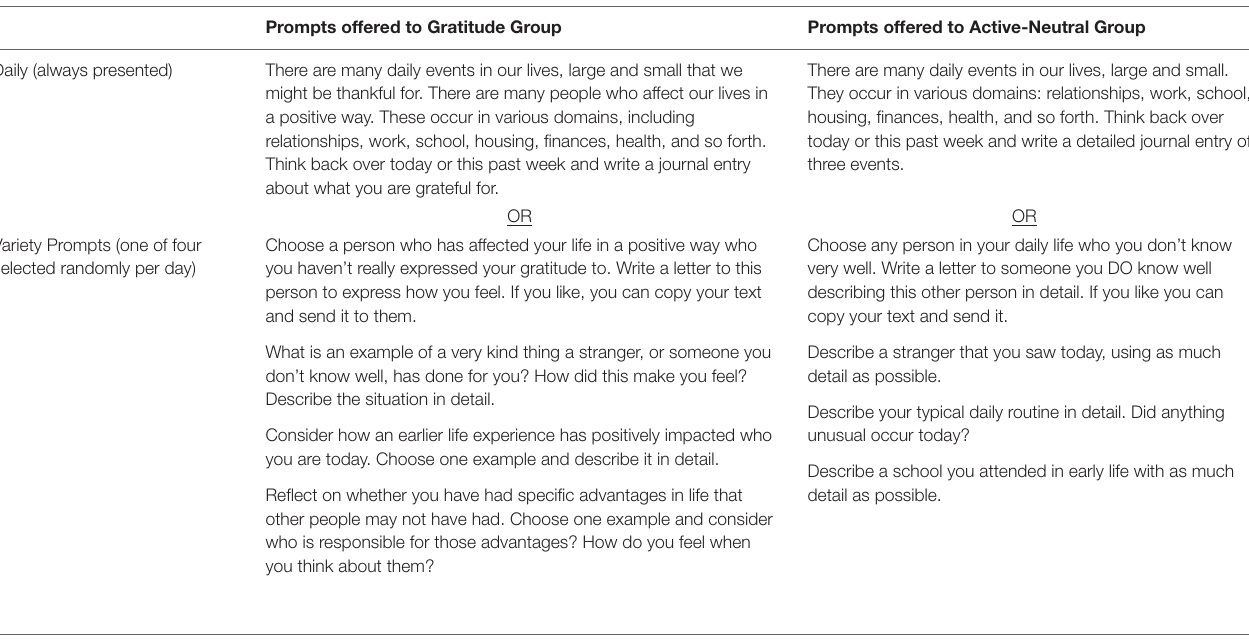
TABLE 3 | Prompts from either the Gratitude or Active-Neutral columns, depending on group assignment, were displayed to participants each time they logged in to the online portal. Welcome to your daily journal entry! Some important items to remember: You will always have two prompt choices. A general prompt that you can use every day if you like, or you may choose to write your journal entry on the second prompt given (one of four different prompts which are provided for variety). Please choose one and try to spend at least 10 min writing in your journal, responding to the prompts with as much detail as you can. Your responses are confidential. To protect your identity, please replace any names with an initial, or simply identify the relationship to you (friend, parent, sibling, roommate, etc.). Choose the daily or variety prompt below to write about